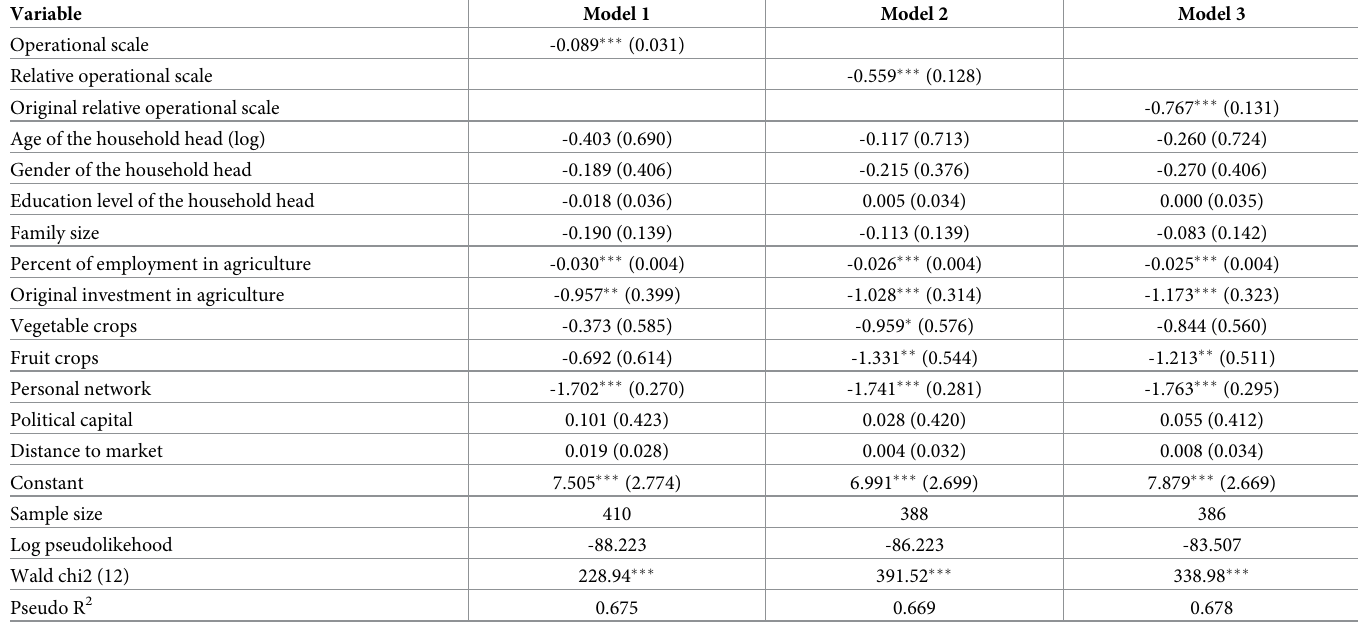
Table 5. Model fitting results (dependent variable: Exclusion by